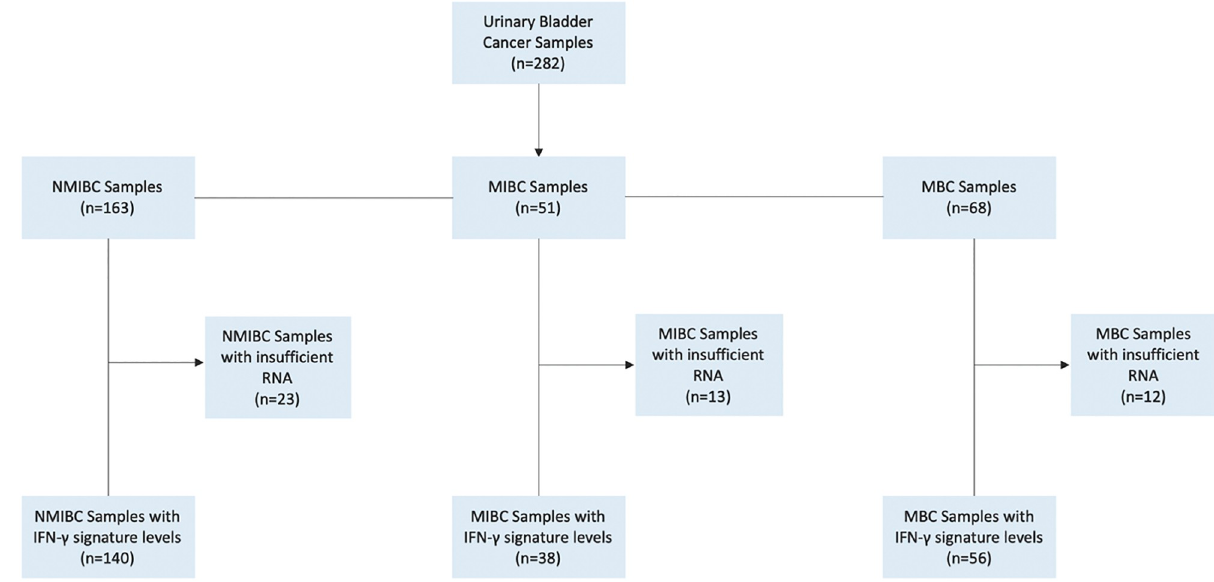
Fig 2. Sample flow diagram. Urinary bladder cancer study. Mt Sinai hospital system and North Shore Long Island Jewish health system, New York, New York. 2004–2017.